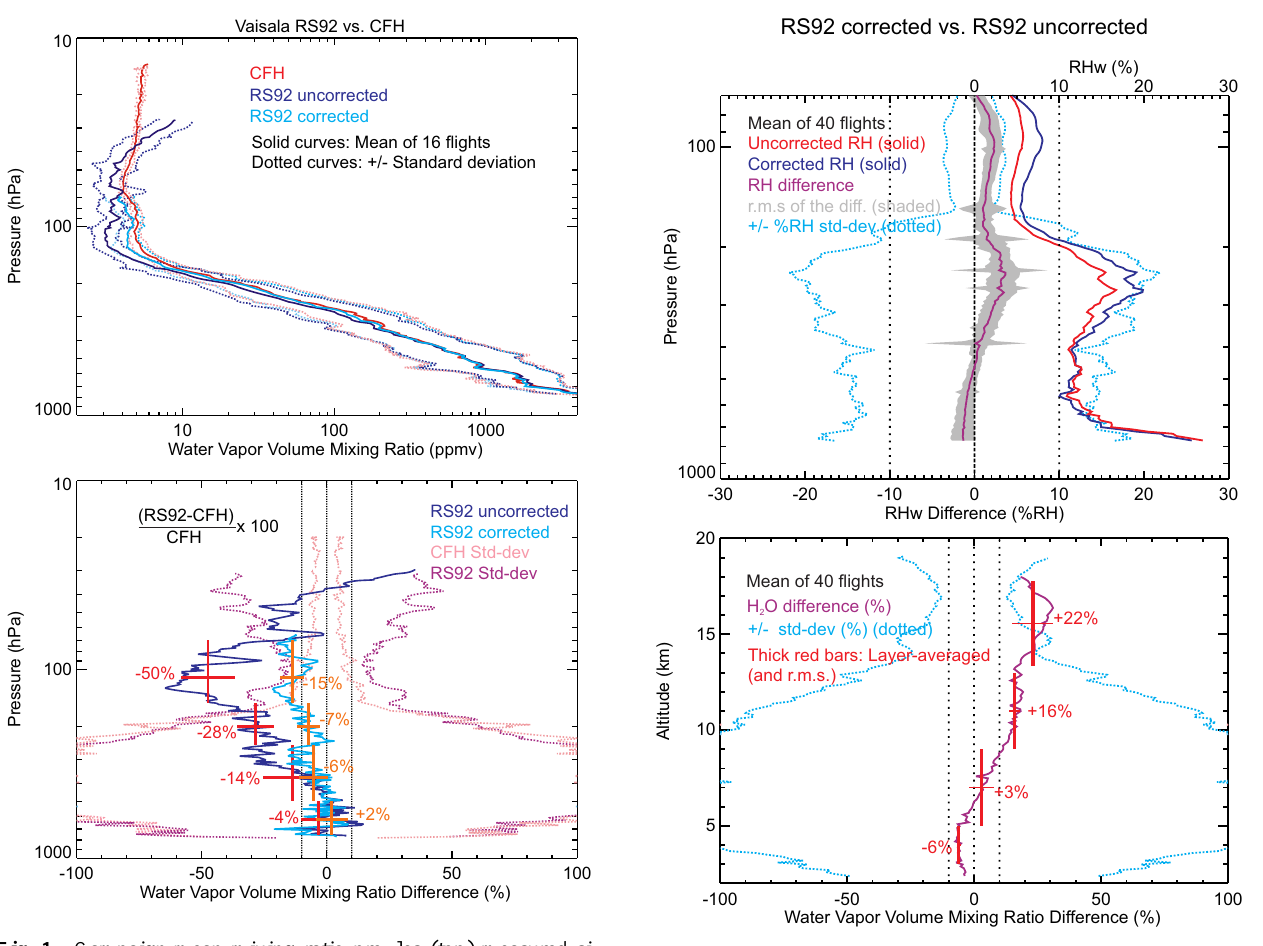
Fig. 2. Campaign-mean RH with respect to water (top) and wa- ter vapor mixing ratio (bottom) difference (purple curves) between the corrected (as described by Miloshevich et al., 2009) and un- corrected RS92 profiles. On the top panel, the uncorrected and corrected RHw profiles are over-plotted using a red and blue solid curve (%RH scale on top-right